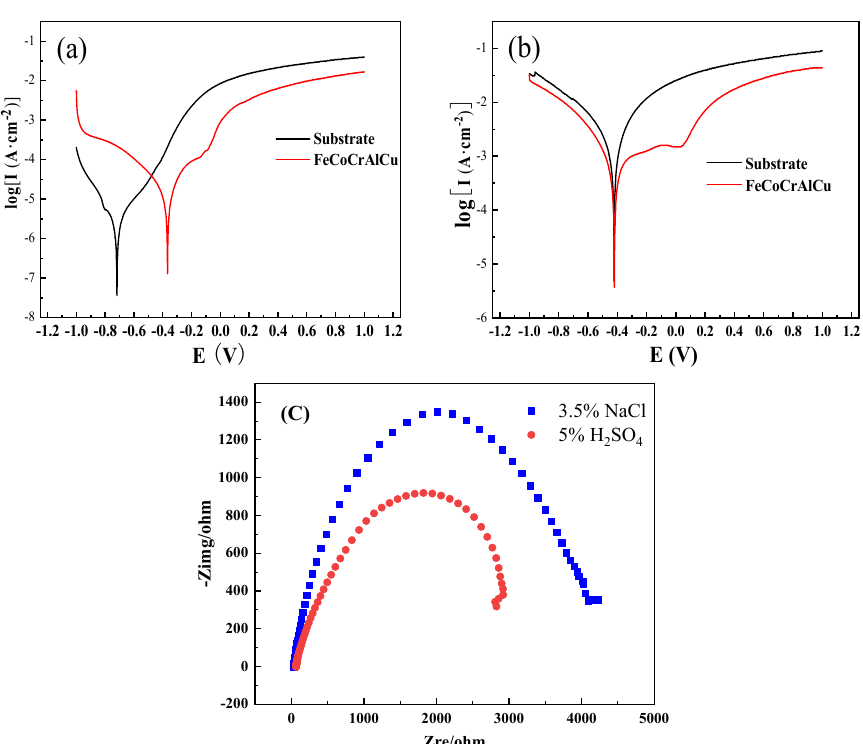
Figure 8. Potentiodynamic polarization curves for the FeCoCrAlCu HEA coating and the 45 steel substrate in two different solutions: ( a ) 3.5 wt.% NaCl and ( b ) 5.0 wt.% H 2 SO 4. ( c ) Nyquist diagram. Table 6. Dynamic parameters derived from the potentiodynamic polarization curves. Corrosion